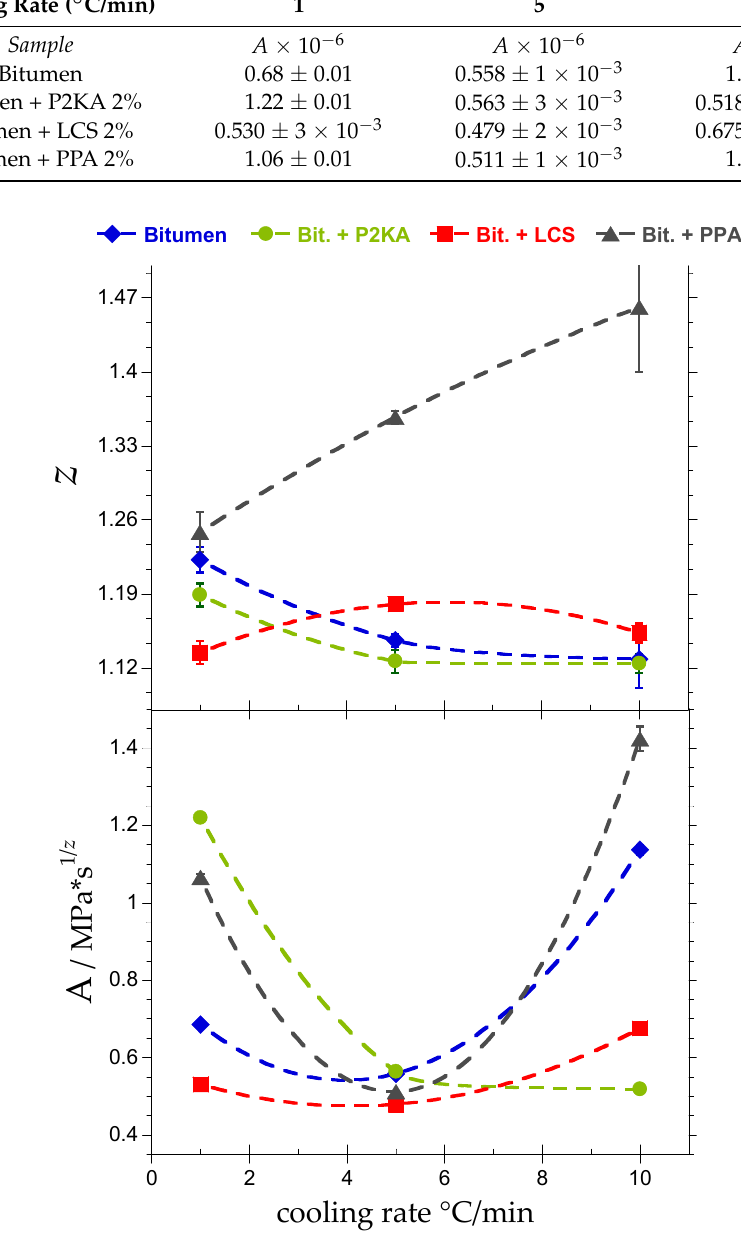
Figure 3. Dependence on the cooling rate of both z coordination number (upper plot) and interaction strength A (lower plot) for neat bitumen (diamonds) and bitumens modified by addition of 2% P2KA (circles), LCS (squares) and PPA (triangles), respectively.